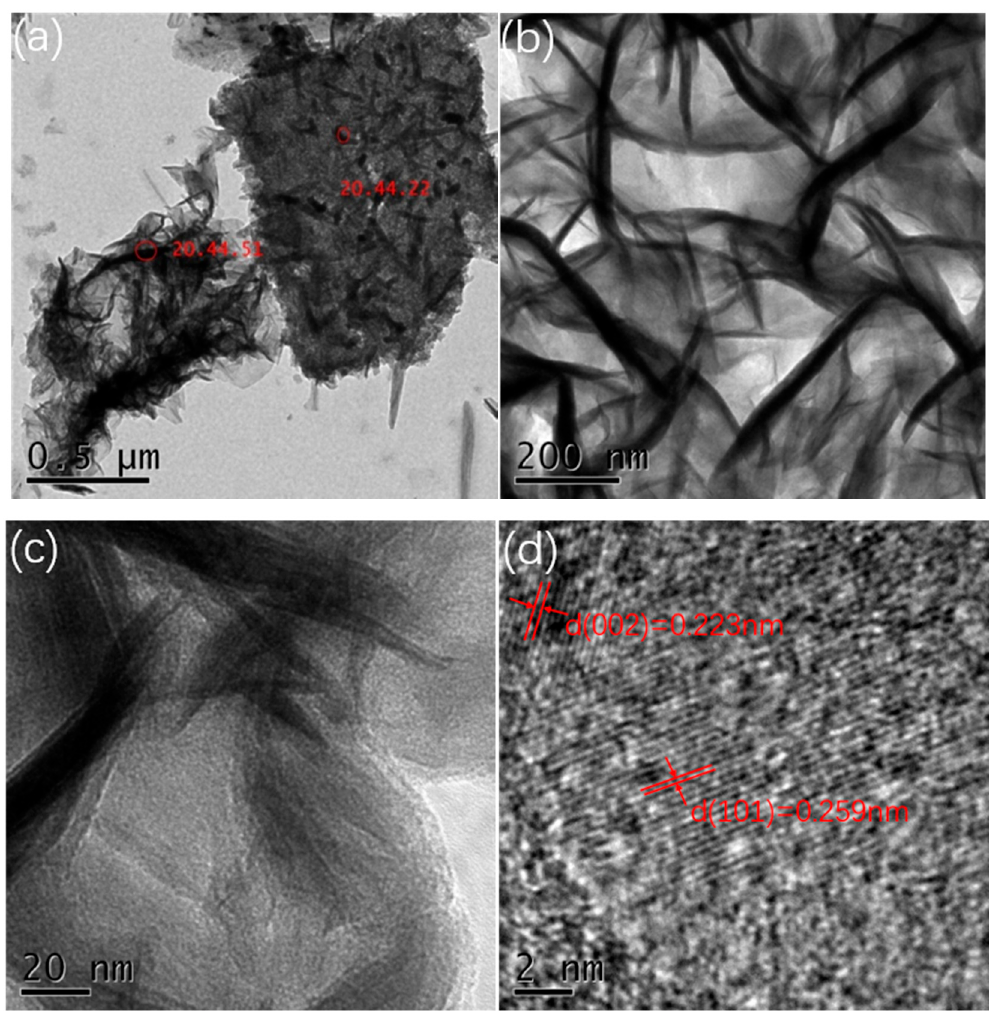
Figure 3. ( a , b ) TEM images at di ff erent magnifications; ( c , d ) HR-TEM images of the nanostrips from Figure 3. (a,b) TEM images at different magnifications; (c,d) HR-TEM images of the nanostrips from the 0.06 M the 0.06 M sample..